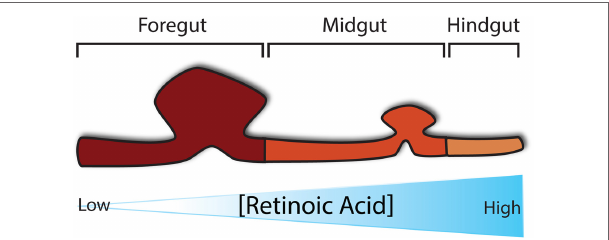
FiGURe 2 | Regional specification of the developing gut . Specification of the developing gut is determined initially by a concentration gradient of retinoic acid along the anterior–posterior axis.